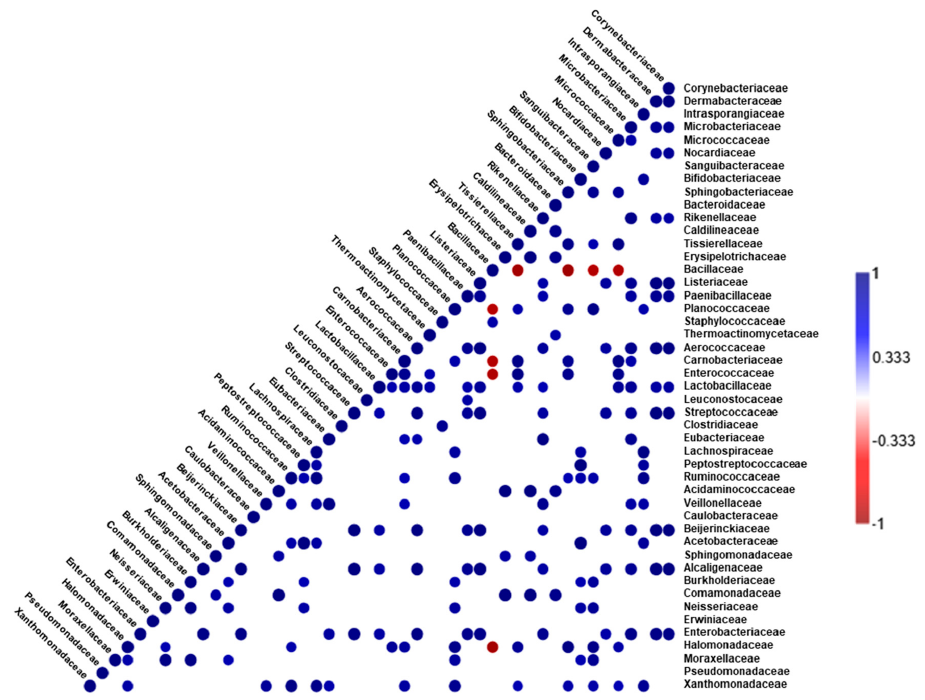
Figure 5. Correlogram representing matrices of Pearson’s correlation coefficient ( r ) between different bacterial taxa in soy sauce samples ( n = 6), at family level. Only significant ( p < 0.05) positive (blue) and negative (red) correlations are shown in the graph.